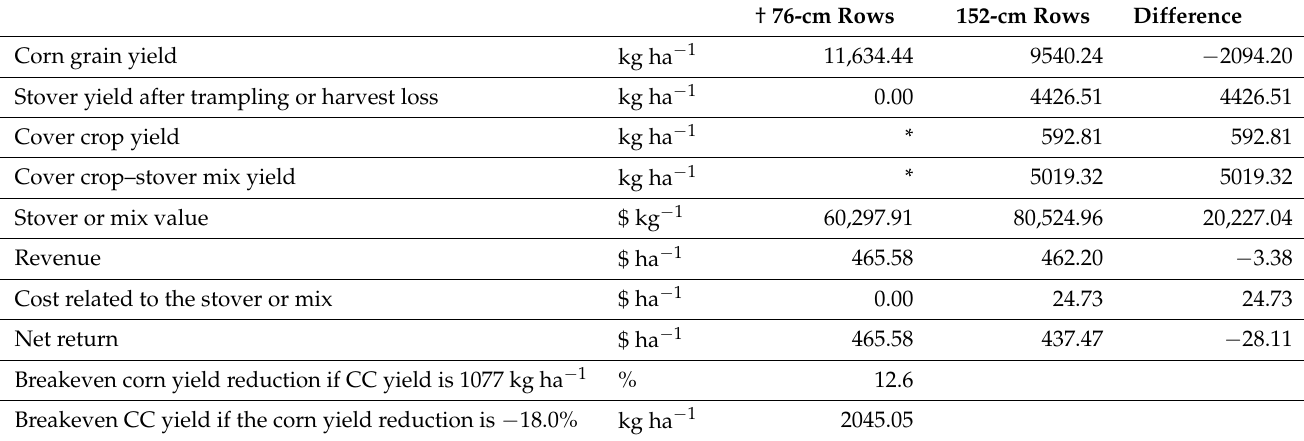
Table 6. Calculation of the yield required to cover the cost of growing the cover crop and reduced yield of corn caused by increasing the row width.